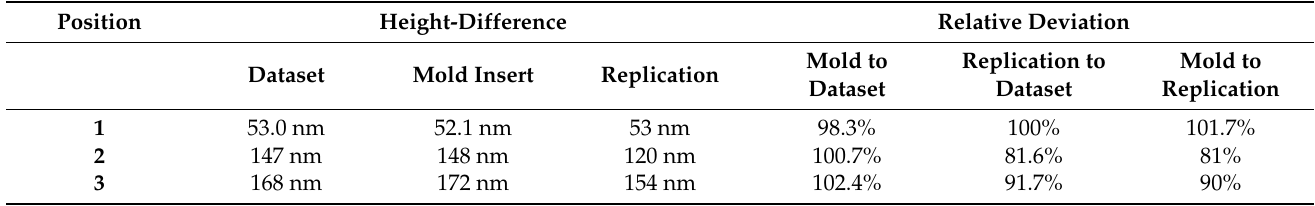
Figure 3. Comparison of mold ( a , c ) and replicated surfaces ( b , d ) with test structure: atomic force microscopic (AFM) measurement and cross section ( a , b ) and coherence scanning interferometric (CSI) measurements ( c , d ). Table 3. Deviation of Structure heights between mold insert and replicated